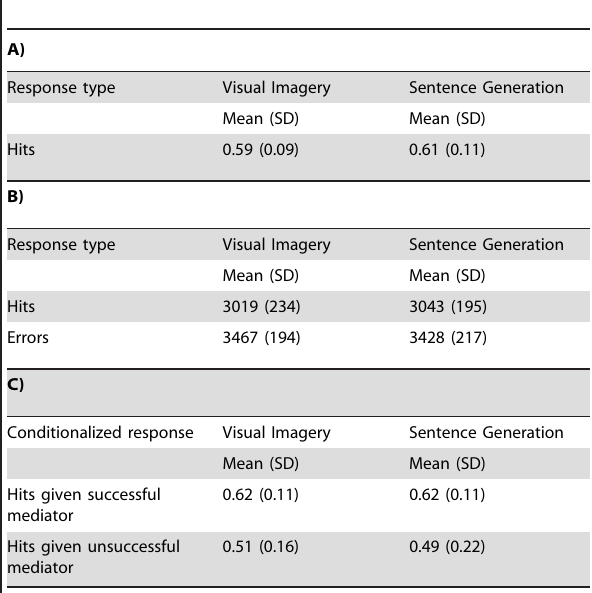
Table 1. Hit rates regardless of mediator success are displayed as a function of study condition in